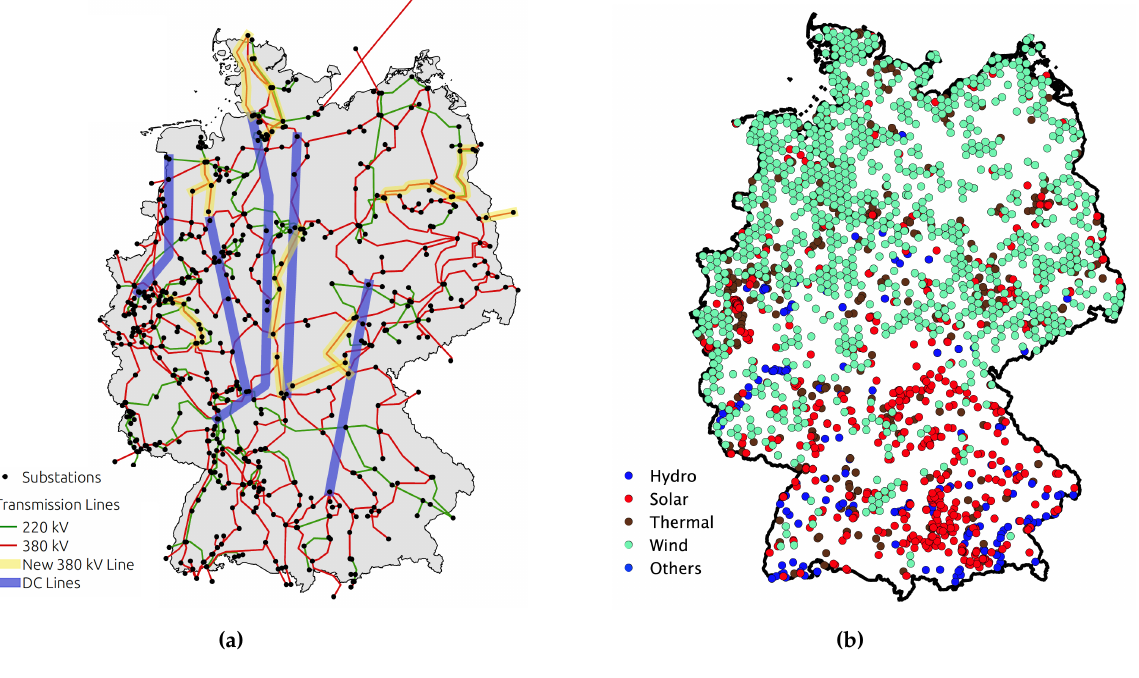
Figure 1. Germany’s planned power system infrastructure by 2020. ( a ) Transmission system; ( b ) Generators.